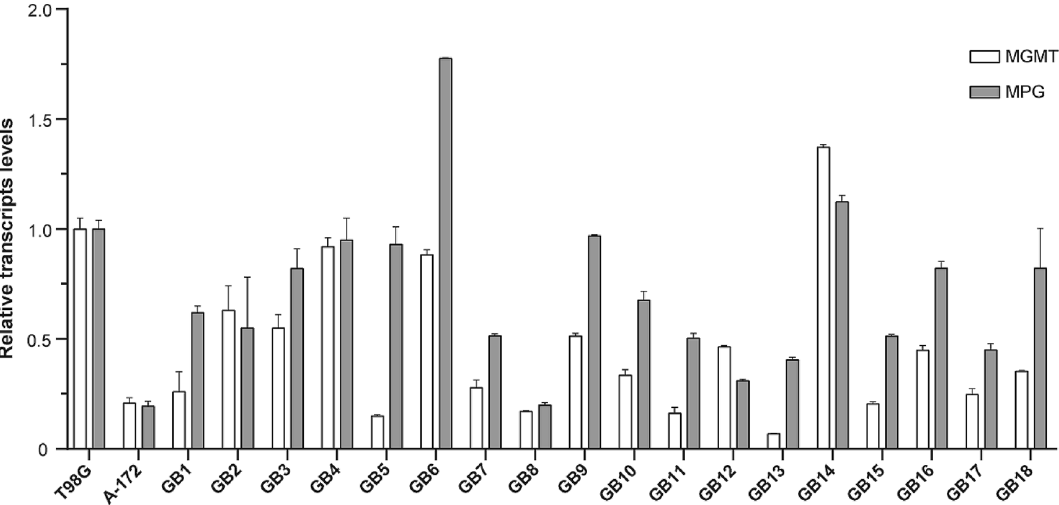
Figure 1. Relative mRNA expression levels of MGMT and MPG in human glioma cell lines (T98G and A-172) and patient-derived glioma cells. Primary cultures were established from the whole resected tumor after surgery. Once glioma cells reached confluence, total RNA was extracted and real-time RT-PCR analyses were performed to measure mRNA levels of the DNA repair enzymes. The histogram shows the MGMT and MPG transcripts amount relative to mRNA levels in T98G, a TMZ resistant-glioma cell line. A-172, a TMZ sensitive cell line, shows the lowest levels of MGMT and MPG. The MGMT mRNA was differentially expressed in primary glioma cells, whereas high mRNA levels of MPG were detected in most cell cultures. All of them had MPG values higher than A-172. Data are presented as mean ± SD; n = 2